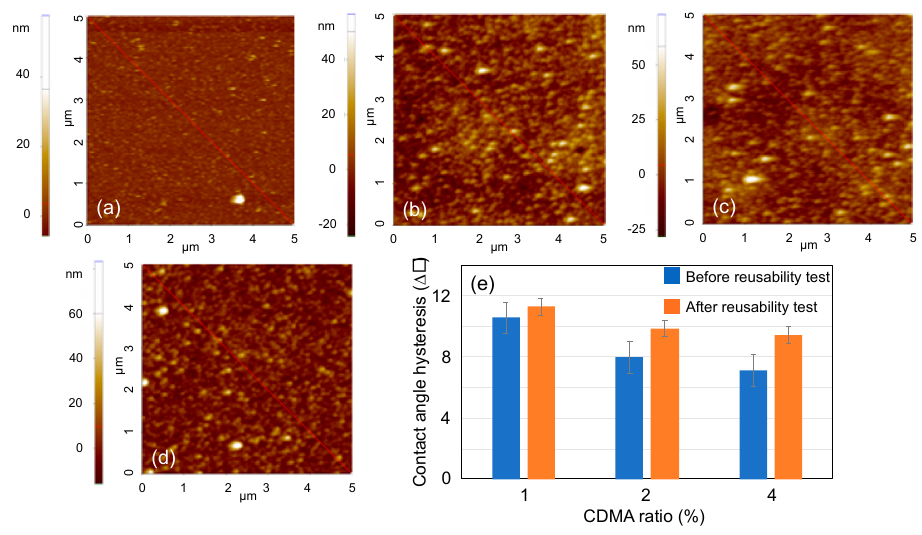
Figure 2. AFM images of Si–RAFT ( a ); PMEMA–CDMA–1 ( b ); PMEMA–CDMA–2 ( c ); PMEMA–CDMA–4 ( d ); Water contact angle hysteresis of PMEMA brush-gels ( e ).